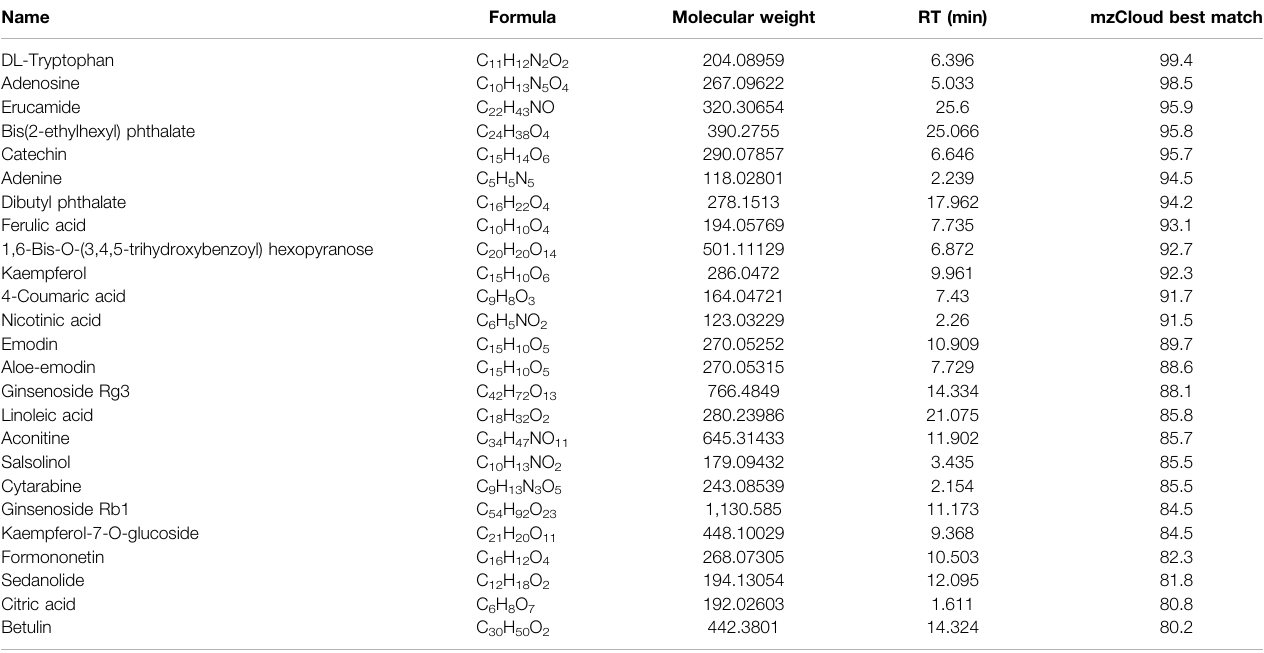
TABLE 1 | Characterization of some chemical constituents in NWXF by HPLC/MS Analysis. Name Formula Molecular weight